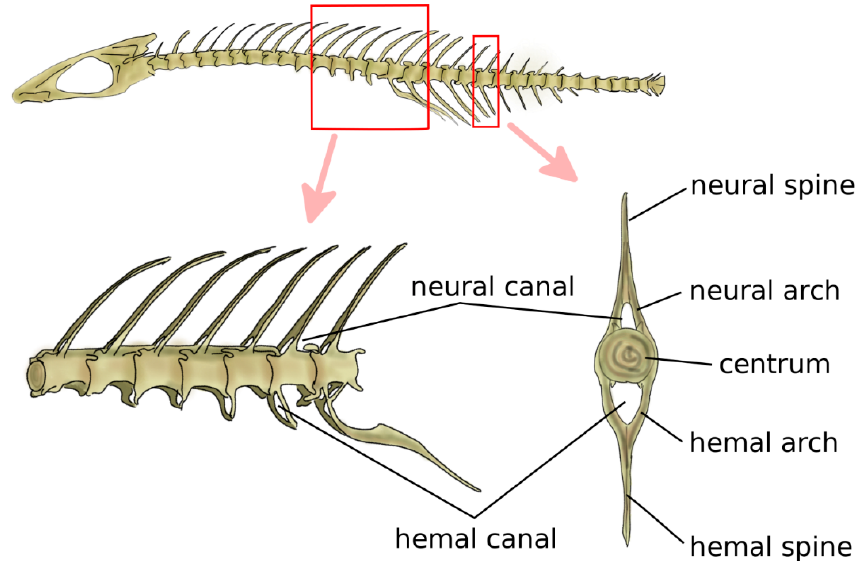
Figure 2. Schematic representation of the spine and vertebral anatomy of a ray-finned fish. Adapted from Reference [32].